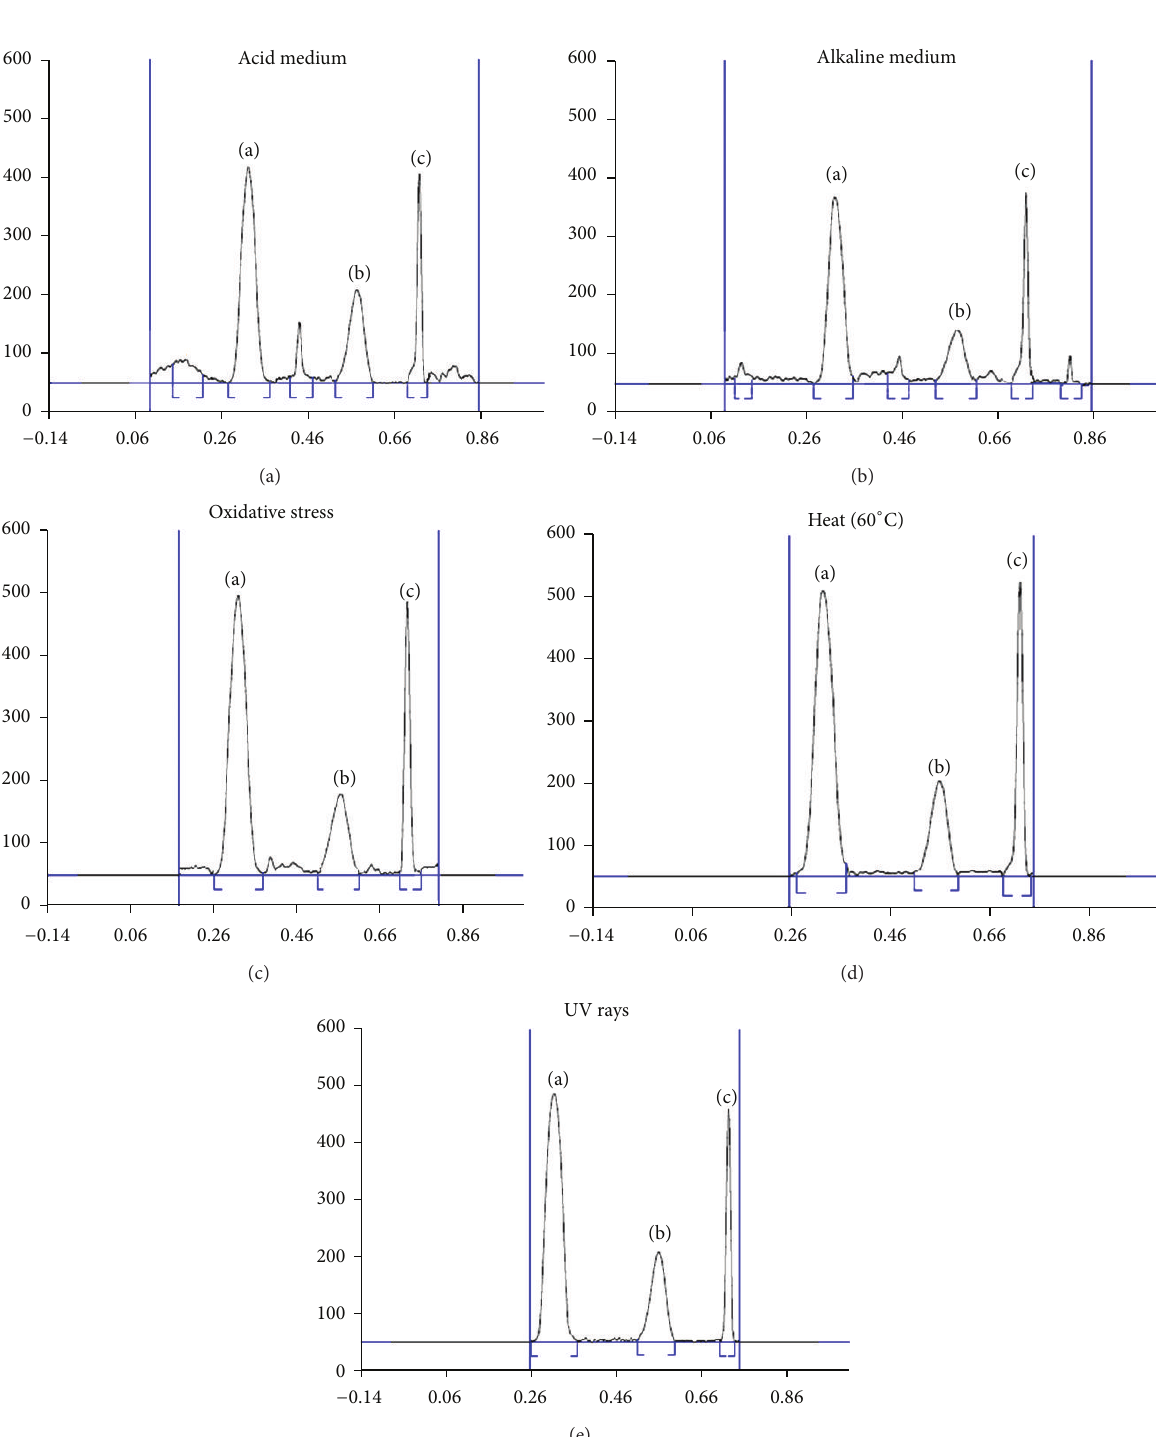
Figure 5: Densitogram obtained after stress testing under different